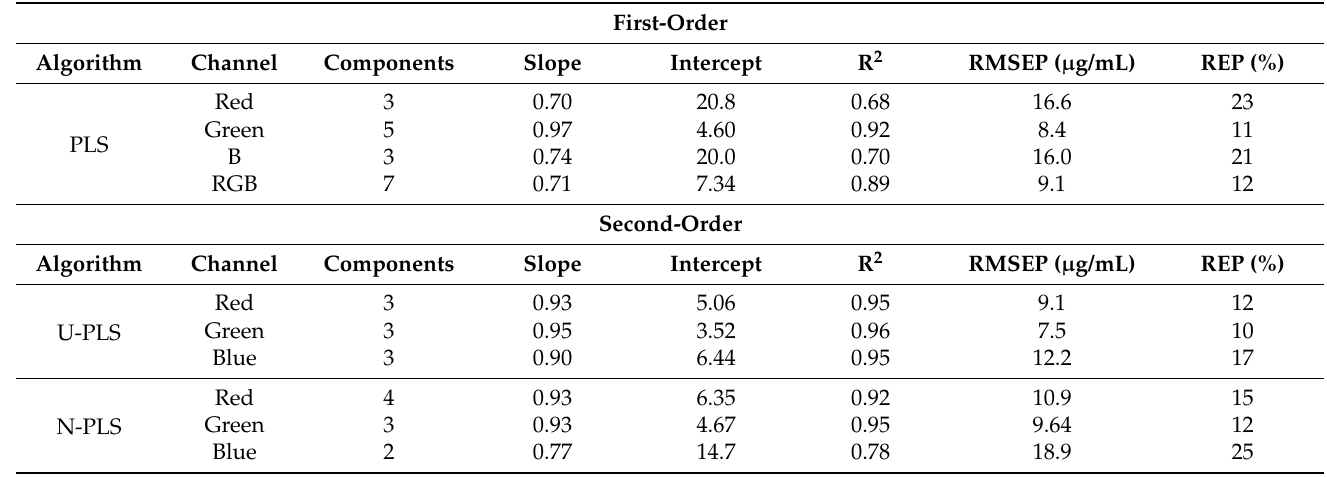
Table 2. Figures of merit for the different regression models obtained for first- and second-order multivariate analysis in the different channels.